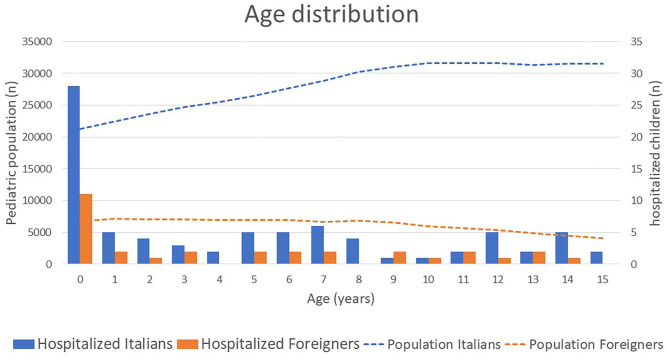
Shows the age distribution of the total pediatric population (lines) and the respective number of hospitalized SARS-CoV-2 positive children (bars).